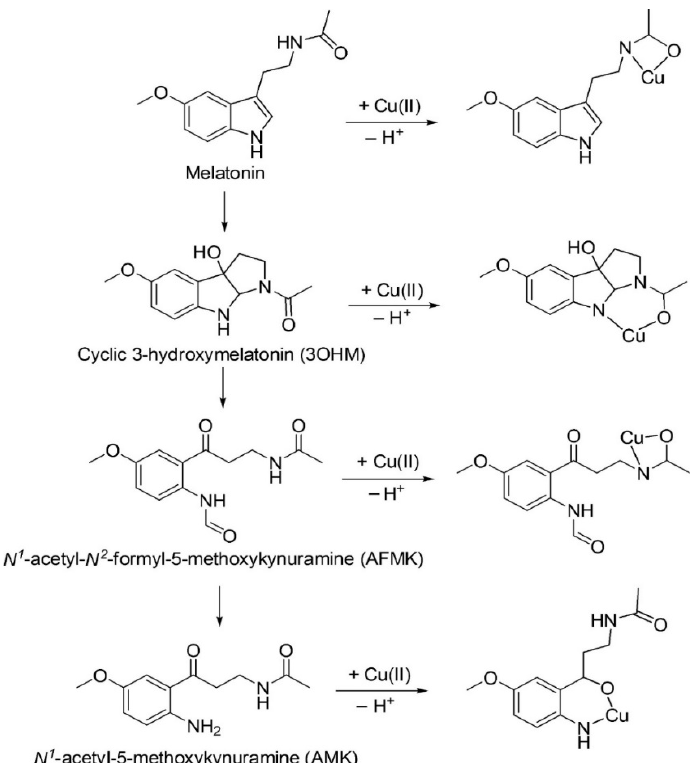
Figure 1. The free-radical-scavenging (vertical, left ) and corresponding metal-chelating cascade (horizontal, right ) of melatonin and its mentioned metabolites. The predicted chelation structures are those that are presumably the most abundant. The proposed mechanism, consistent with the predicted complexes, is a coupled deprotonation–chelation mechanism (CDCM). From Galano et al. [10], with permission.